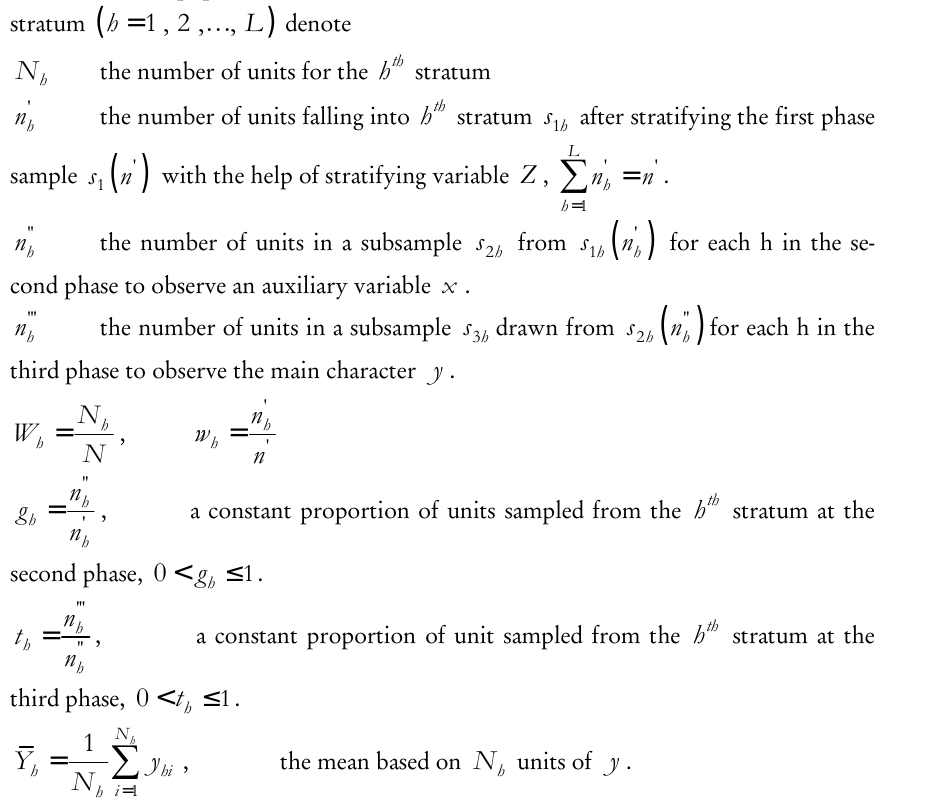
( ) ' s from n for each h in the se- 2 h 1 h ( s drawn from n for each h in the 3 h